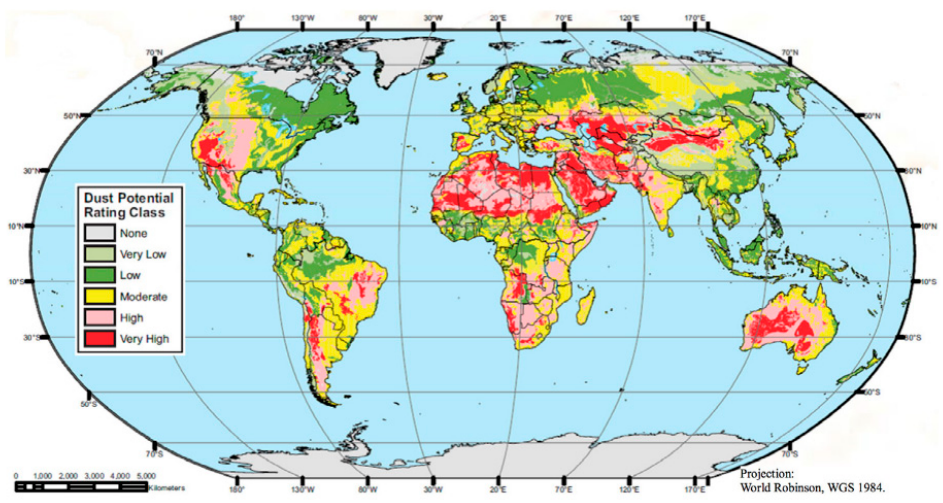
Figure 1. Map of areas with the highest dust amount [11].